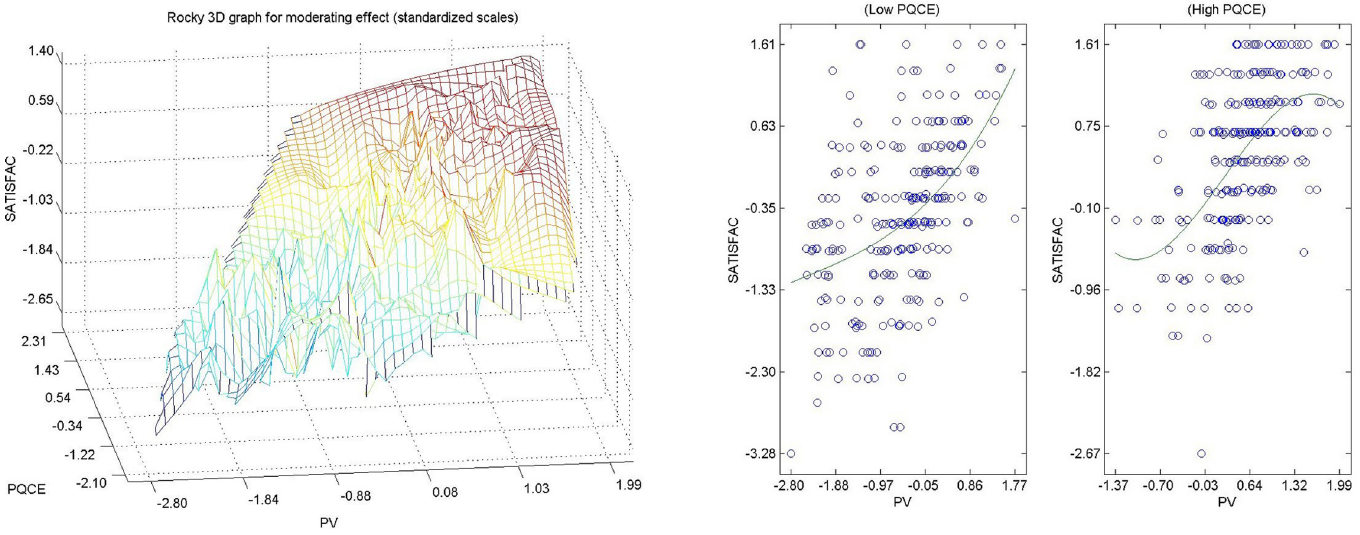
Fig 11. a. Hypothesis 9 3D, PQCE- > PV-SATISFAC. b. Hypothesis 9 2D, PQCE- >